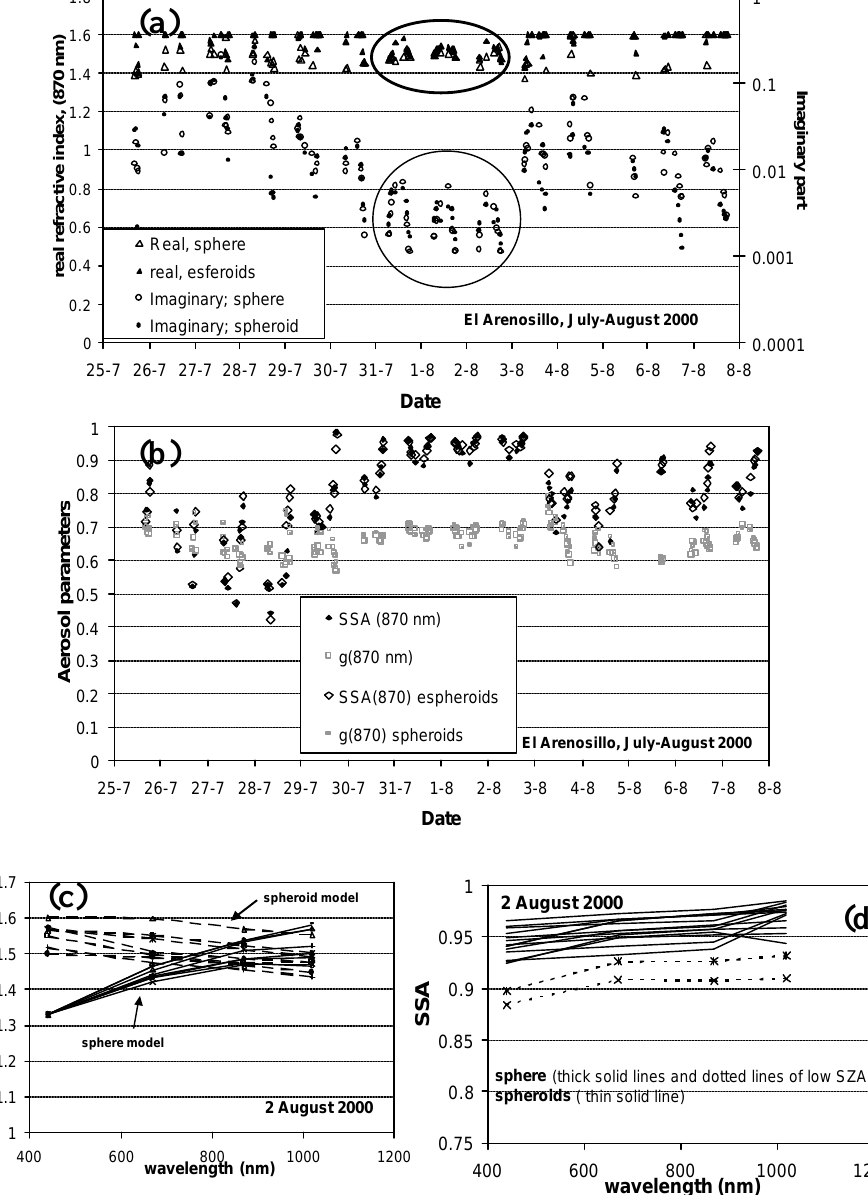
Fig. 10. Evolution of (a) the real and imaginary parts of the refractive index, (b) single scattering albedo and asymmetry parameter during the desert dust event of July–August at El Arenosillo, obtained by the AERONET inversion protocol. (c) Dependence on the wavelength of (c) the real part of the refractive index and d) single scattering albedo for sphere and spheroid models for day 2